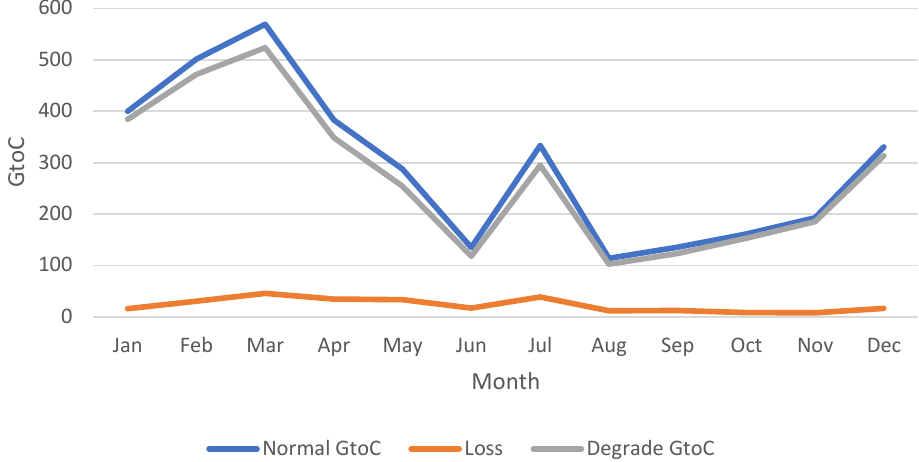
Figure 17. Illustration of dust impact on GtoC .